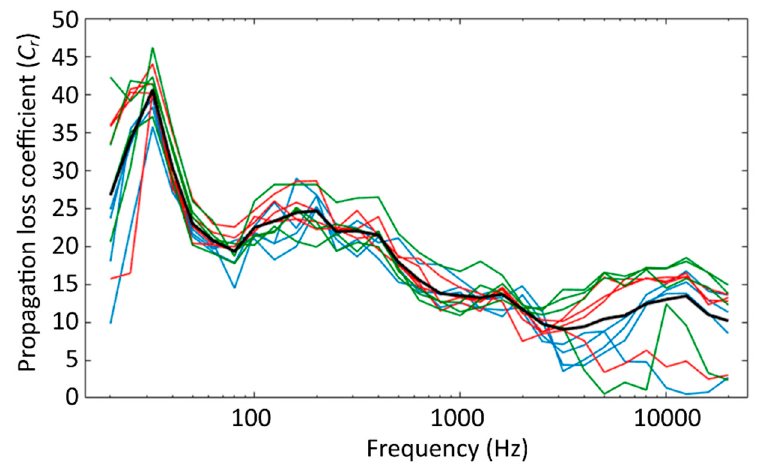
Figure 8. One-third octave band propagation loss coefficients ( C r ) determined from linear regression for Primrose , Macquarie and Kirsty K (blue, red and green, respectively). Mean one-third octave band propagation loss coefficients across all vessels and speeds shown by the black line.